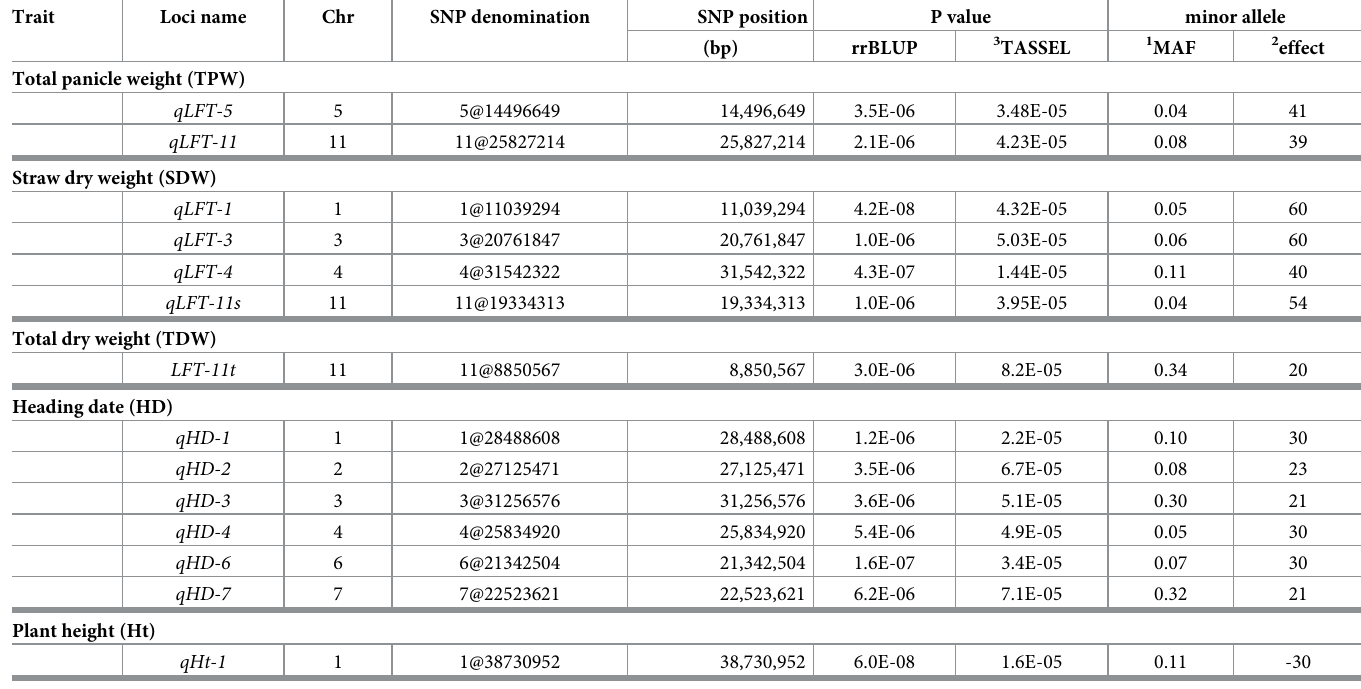
Table 1. Summary of quantitative trait loci (QTL) associated with low fertility soil for several agronomic traits using a mixed linear model (MLM).